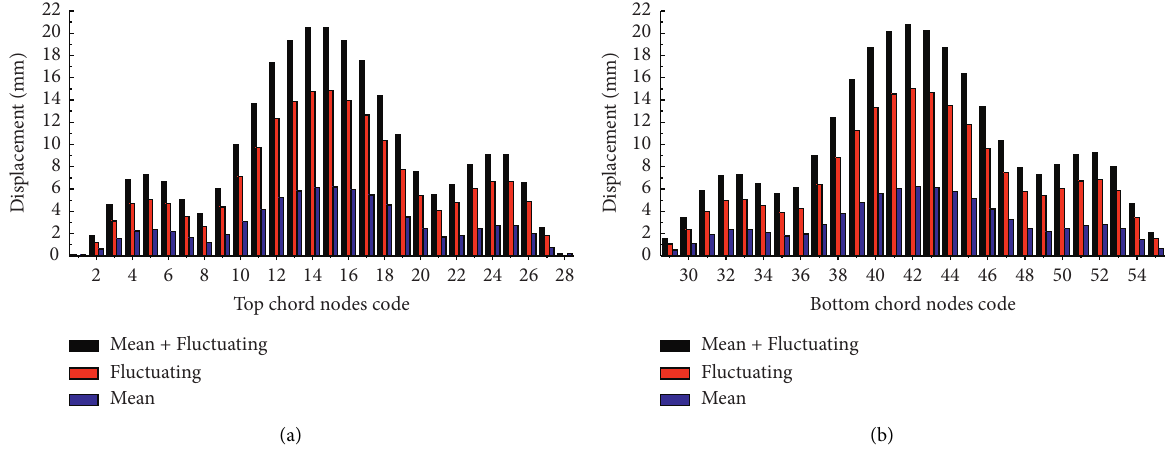
Figure 10: Distribution curves of the maximum displacement at nodes of plastic greenhouse. (a) Top chord. (b) Bottom